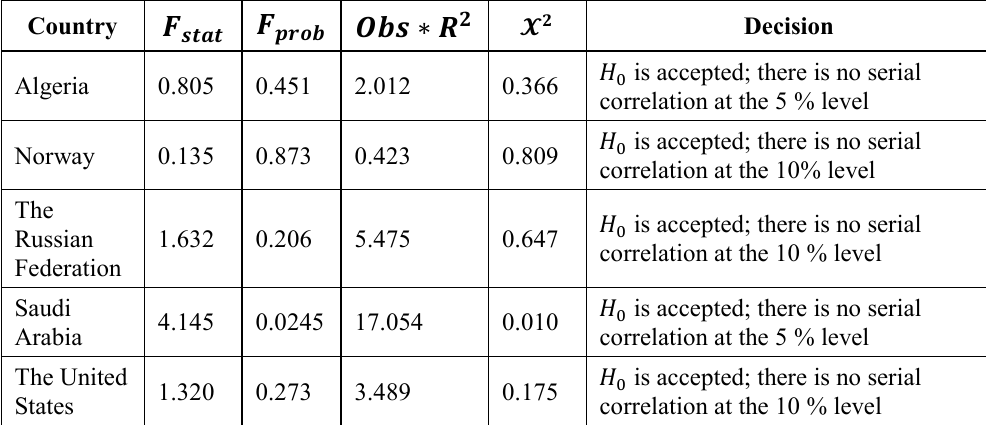
Table 2. Breusch–Godfrey Serial Correlation LM Tests